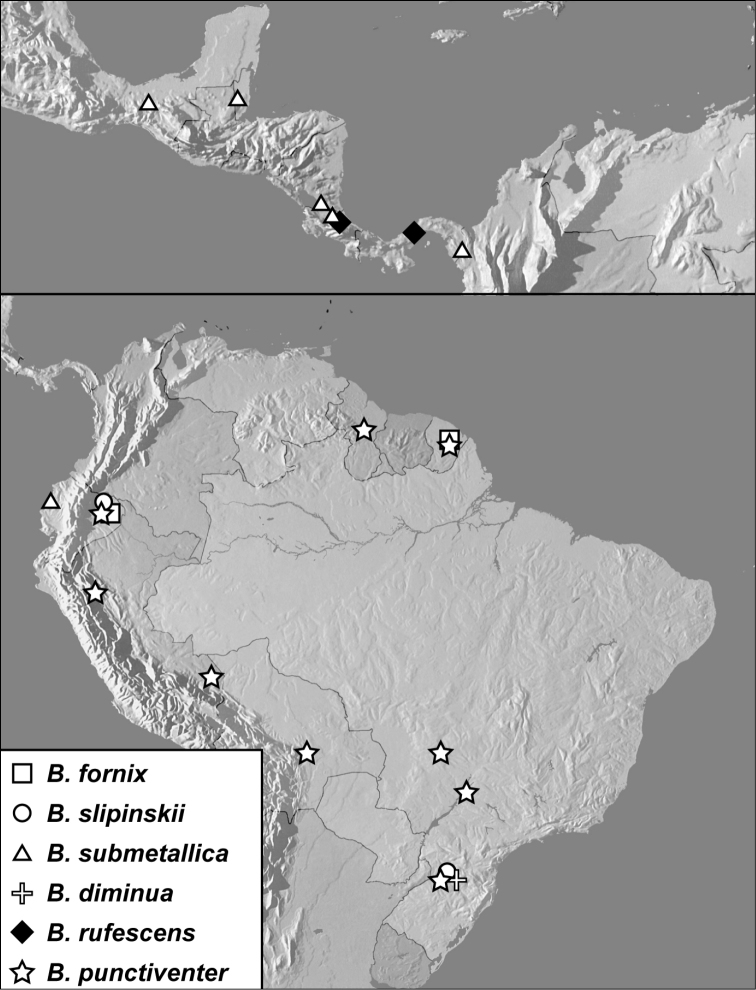
Baconia aeneomicans group records.